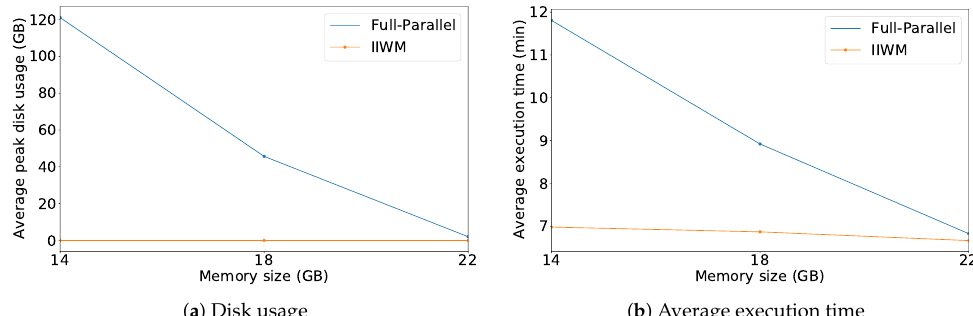
Figure 11. Average peak disk usage and execution time, varying the size of available